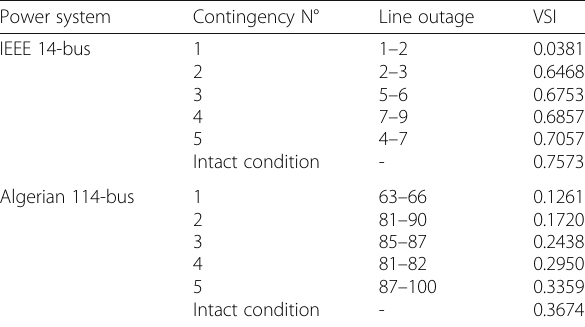
Table 2 Set of the critical contingencies of IEEE 14-bus and Algerian 114-bus systems Power system